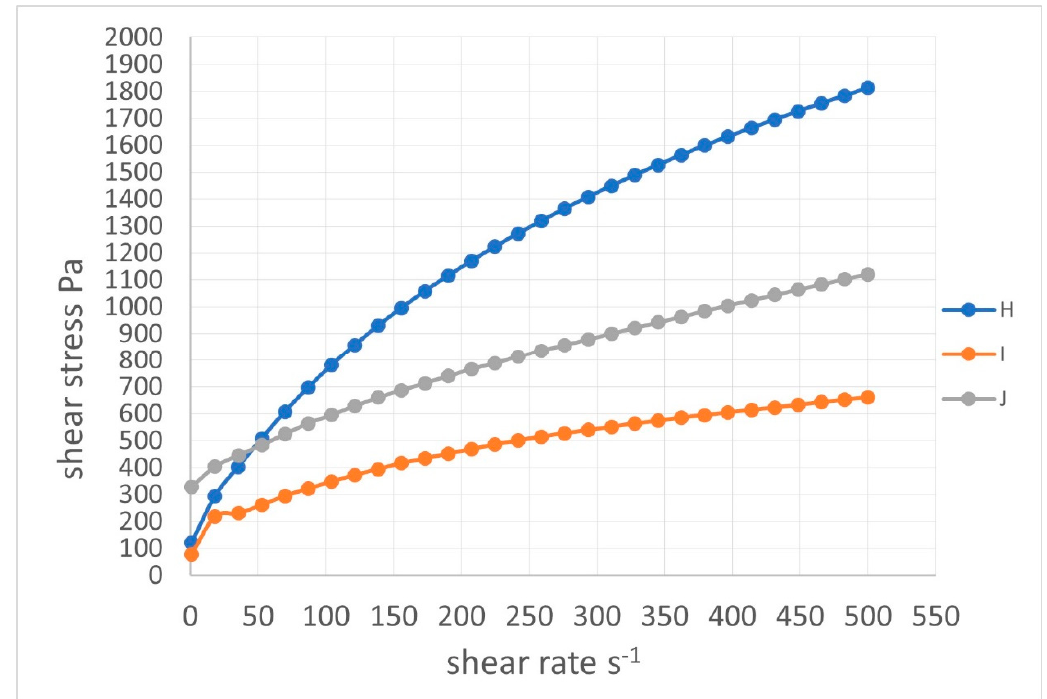
Figure 3. Flow curves of samples belonging to a physicochemical form group–ointments.